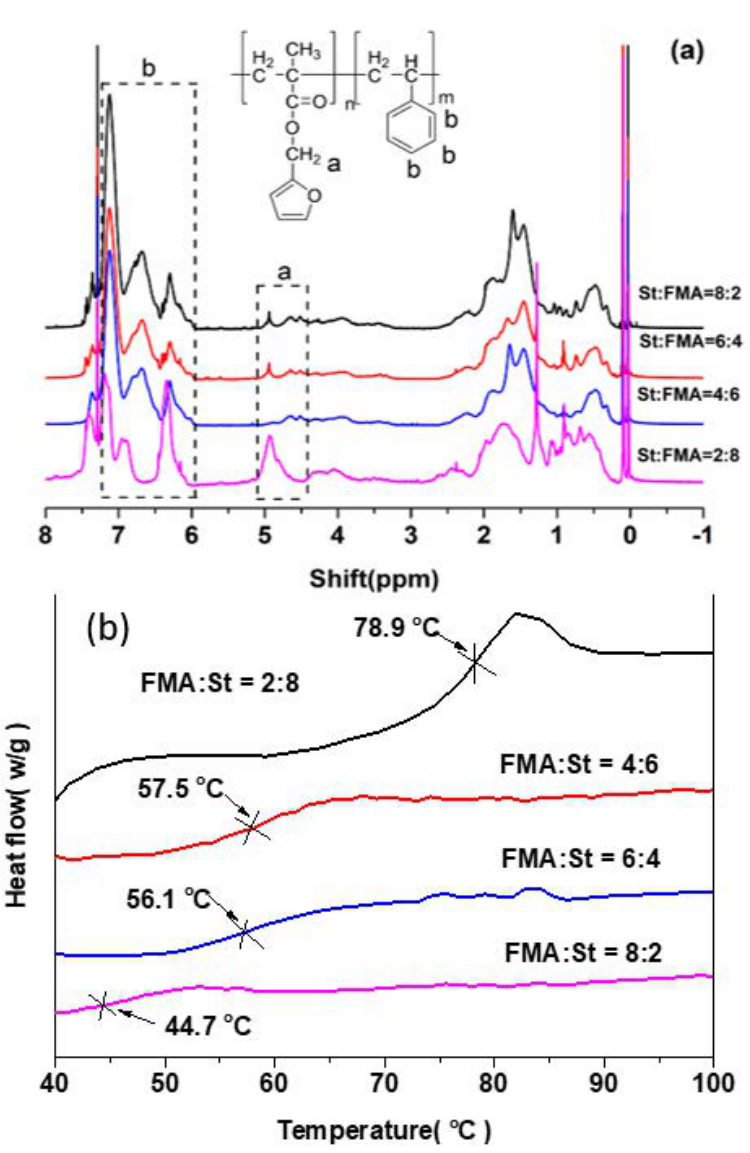
Figure 3. ( a ) 1 H NMR spectra and ( b ) DSC curves of copolymer P(St- co -FMA) with different monomer feeding